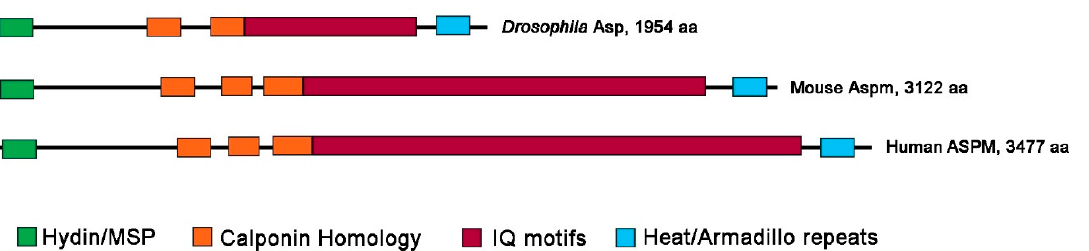
Figure 1. Domain structure of the major isoforms of the Drosophila Asp, mouse Aspm, and human ASPM proteins. The N terminal region of the Asp/ASPM proteins contains a Hydin or ASH (ASPM, SPD-2, Hydin) domain, which overlaps with the major sperm protein (MSP) domain. The central part of the proteins contains calponin homology (CH) domains and multiple calmodulin-binding IQ motifs. At the C terminus of the three proteins, there is a conserved Heat/Armadillo repeats domain. (The protein structure analysis is mainly from Rujano et al.